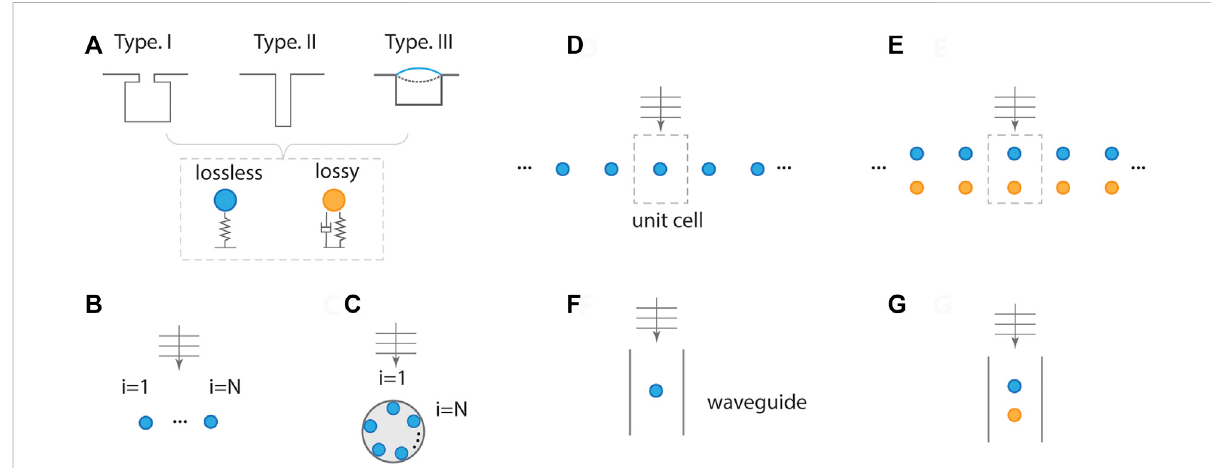
FIGURE 1 Types of coupled resonators. (A) Types of acoustic resonators (Type.I: Helmholtz, Type.II: quarter-wavelength, Type.III: membrane) with and without loss. Finite number of resonators in a linear array (B) and circular array (C) . Periodic structure for a single resonator in a unit cell (D) and two resonators in a unit (E) . Single resonator in a waveguide (F) and dual resonators in a waveguide (G)